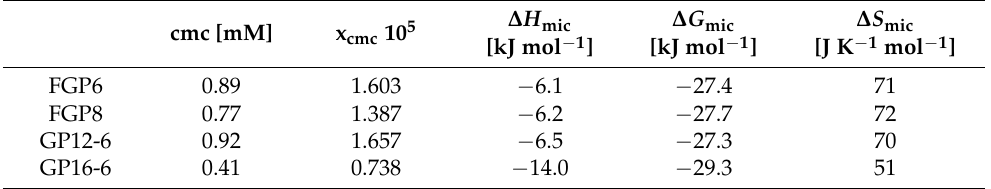
Table 1. Thermodynamic parameters for micelle formation of the surfactants under study.